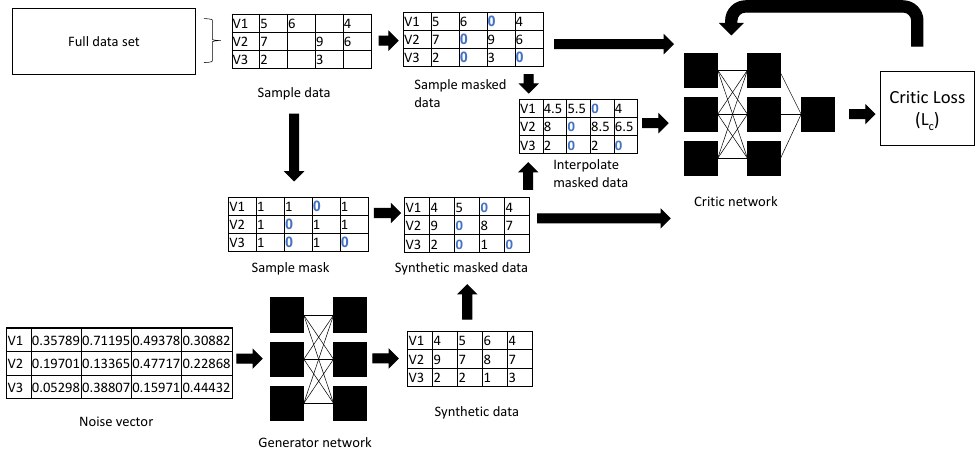
Figure 1. Flowchart for a single training step of the generator.